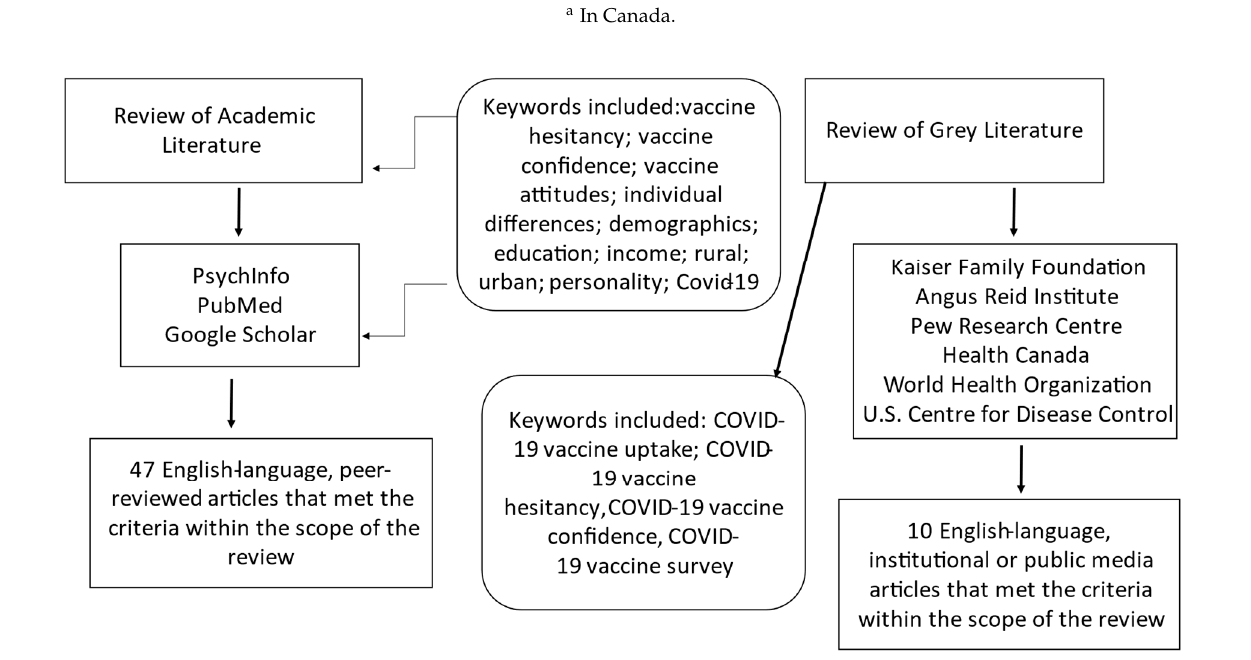
Figure 1. Search strategy for selecting articles from the academic and grey literature. Table 1. Summary of key findings organized by predictor and by population.